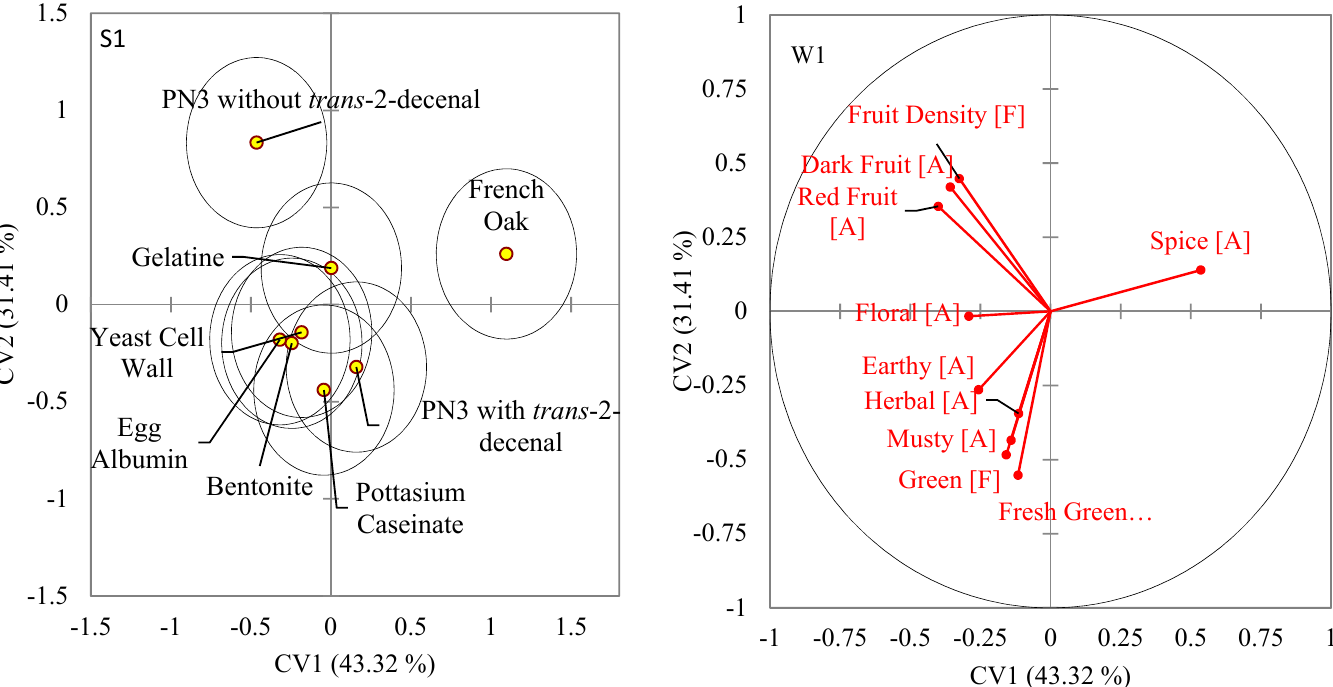
Figure 2. Separation between PN3 without trans -2-decenal, PN3 with trans -2-decenal (23.88 µ g/L) and PN3 containing trans -2-decenal (23.88 µ g/L) when treated with fining agents (Gelatin, Bentonite, Yeast cell wall, Potassium caseinate, Egg albumin, French oak). Wines are positioned using the centroids. Circles represent 95% confidence intervals surrounding the wine means. Vectors for sensory terms (A = aroma, F = in mouth flavor) are in W1 and scores for wines are in S1. Significant differences for wines are for circles that do not touch in S1.